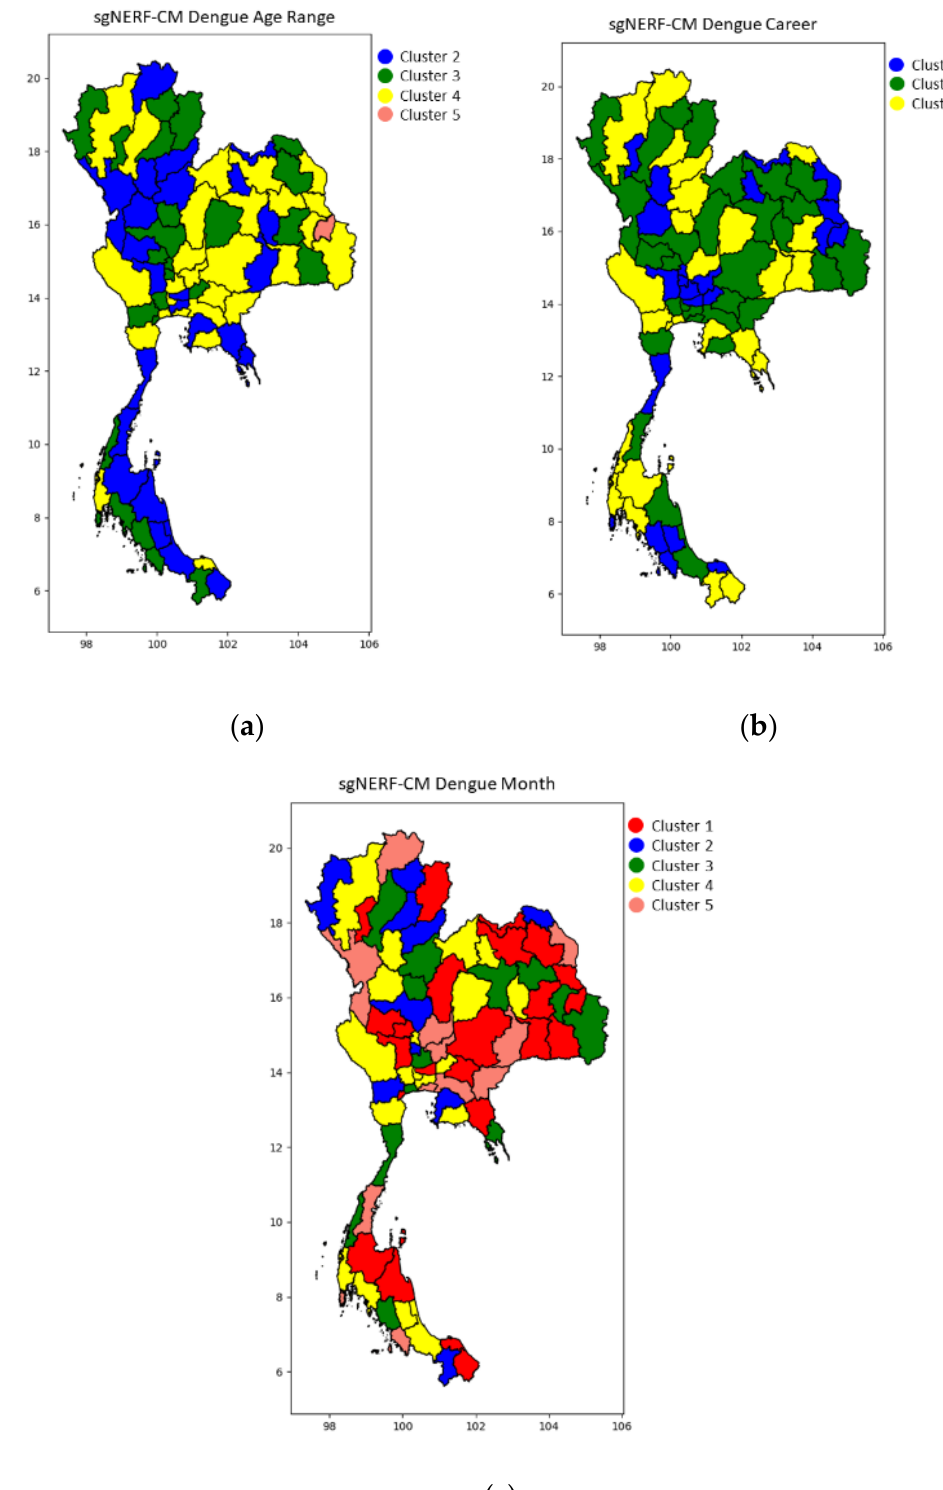
Figure 2. The blind test results for the dengue fever dataset for ( a ) age range, ( b ) career, and ( c ) month category using the best models from sgNERF-CM algorithm.